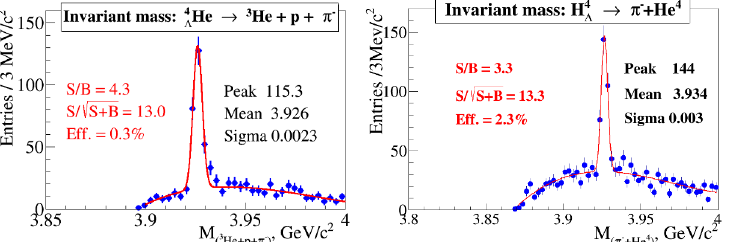
Figure 3. Left) reconstructed invariant mass of 4 Λ He 3-prong decay mode; right) reconstructed invariant mass of 4 Λ H 2-prong decay mode